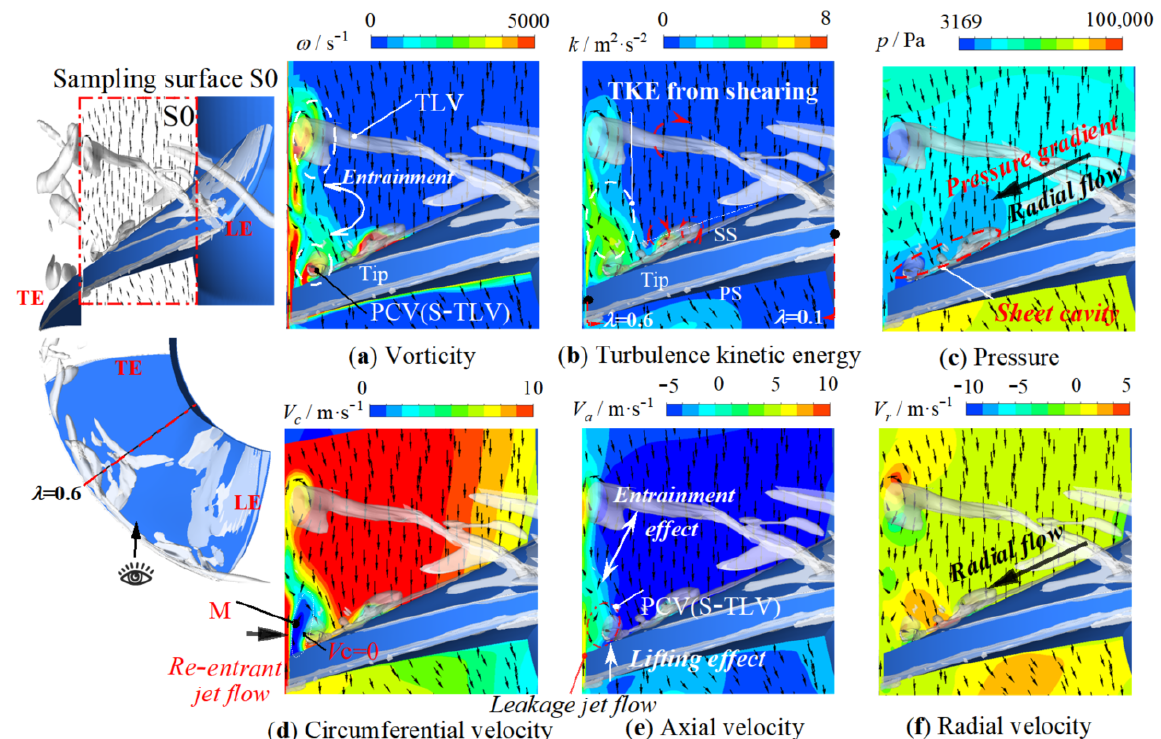
Figure 9. Distribution of plane physical quantities in the initial stage of the PCV at t = t 0 + T/30 (swirling strength isosurface Sw = 1000 s − 1 (white), Q = 0.8 Q BEP , σ = 0.35).